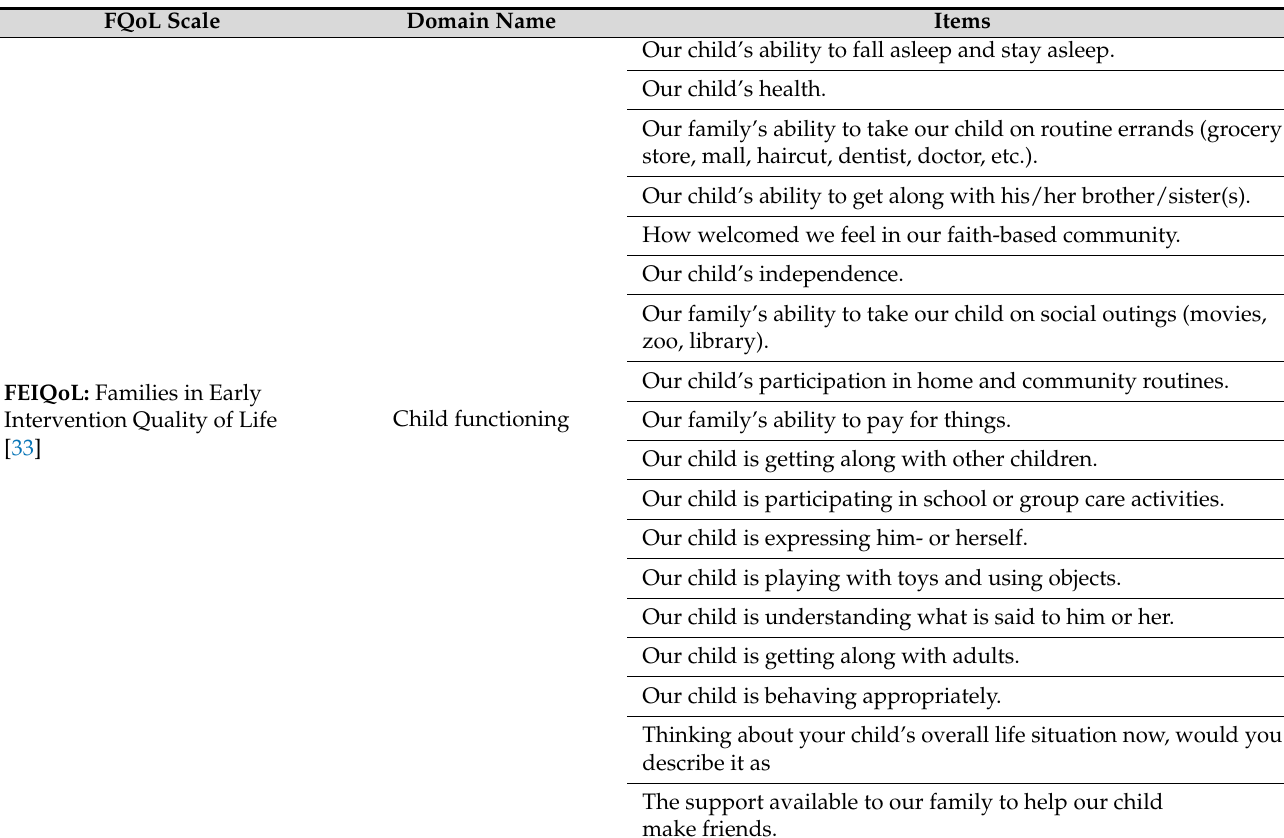
Table 15. Items considered in the domain of child functioning within each FQoL scale. FQoL